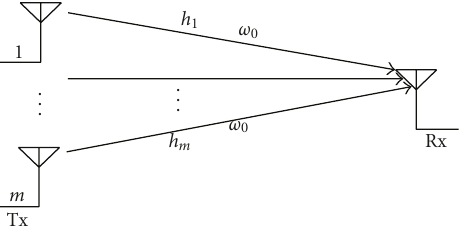
Figure 1: MISO system considered in the